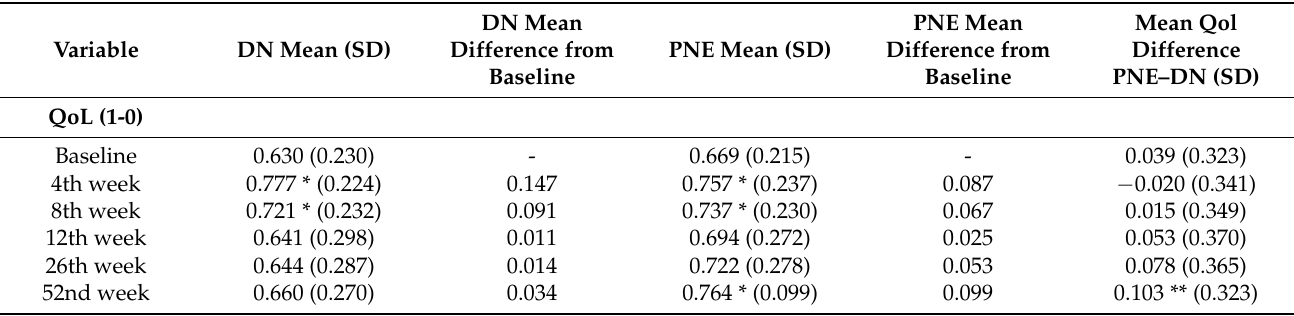
Table 3. Mean quality of life (QoL) from EQ-5d.